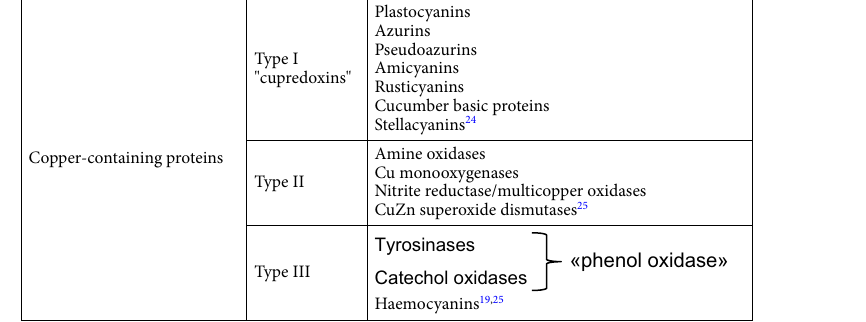
Table 1. Classification of copper-containing